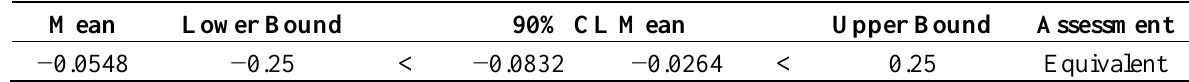
Table 3. TOST results for 500 m